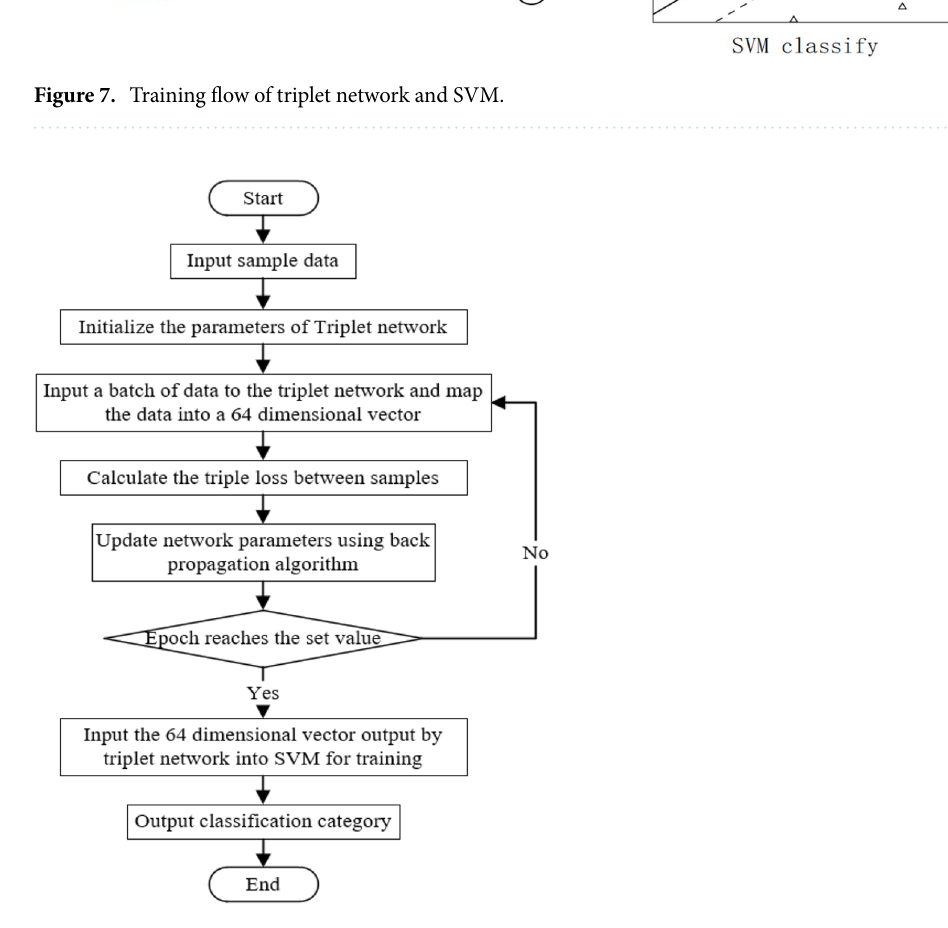
Figure 8. Block diagram of the proposed